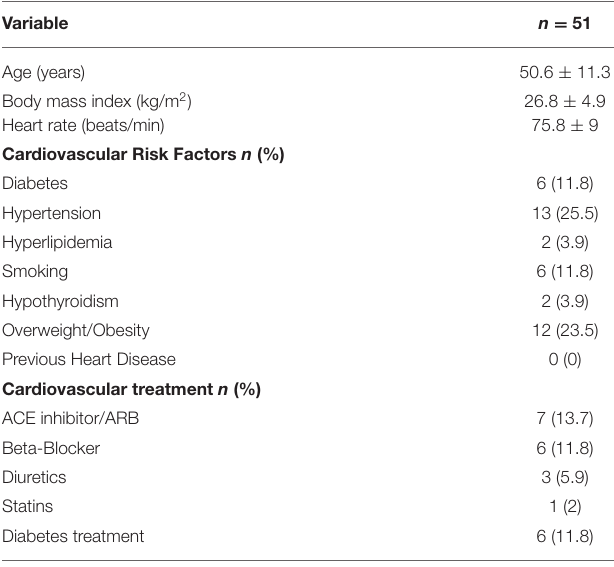
TABLE 1 | Baseline clinical characteristics of the patients. Variable n = 51